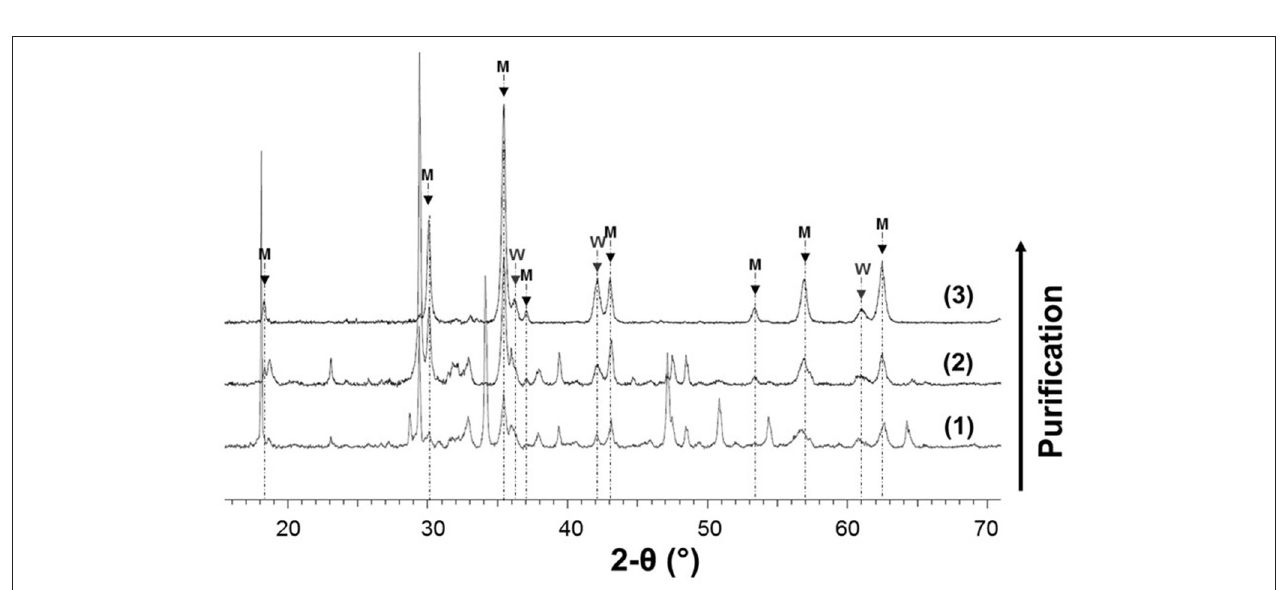
FIGURE 4 | XRPD patterns before and after the two magnetic separation steps; (1) oxidized steel slag before separation ( APW-300C) ; (2) solid fraction after the first magnetic separation in water; (3) solid fraction after the second separation step in HCl (2%); M and W stand for magnetite and wüstite, respectively; unidentified peaks in (1) and (2) are related to calcium-bearing phases initially present in the hydrothermally treated steel slag (see Table 2 ).